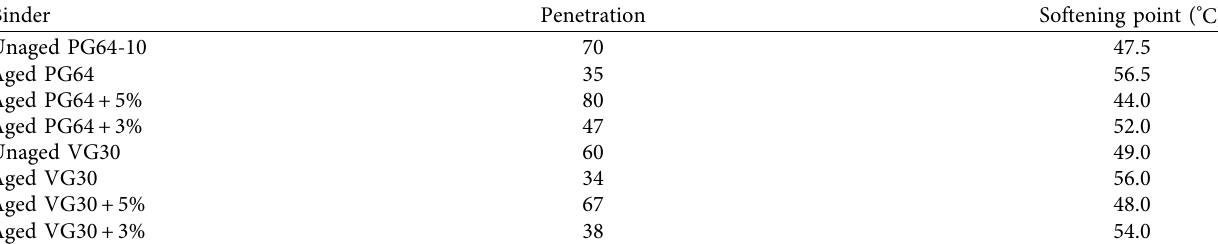
Figure 3: Degree of coating in aggregates. (a) Well coated, (b) moderately coated, and (c) poorly Table 1: Penetration and softening point temperature.